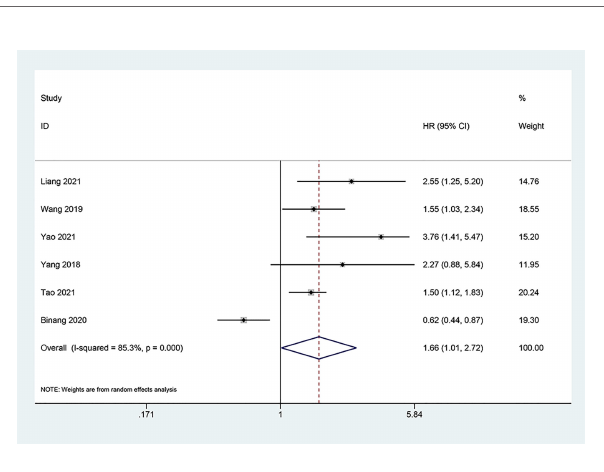
FIGURE 4 | Forest plots for association of FOXP4-AS1 expression with disease-free survival.